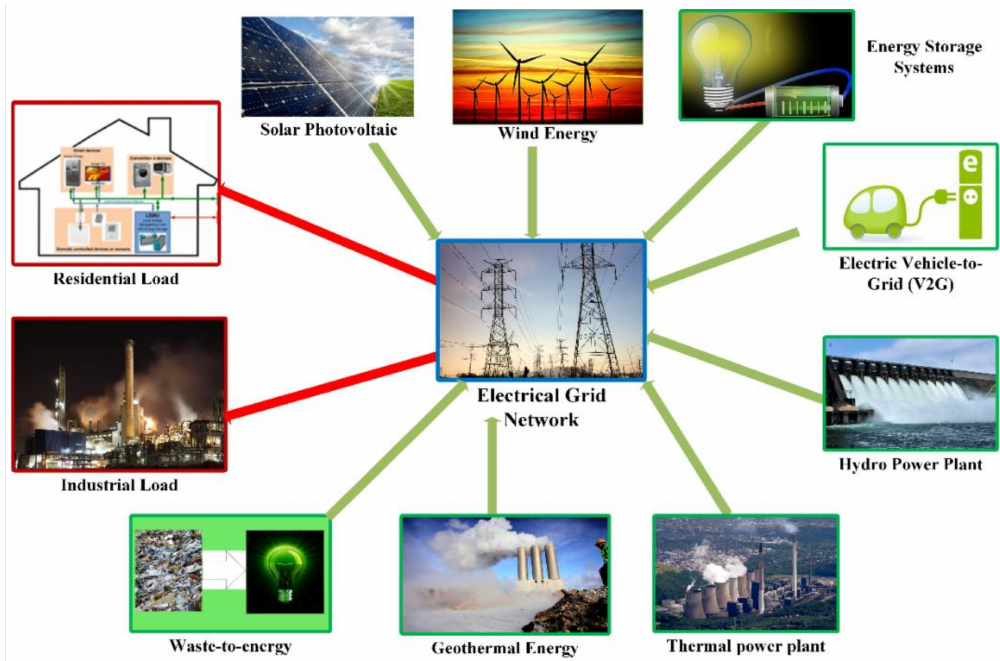
Figure 4. Various types of energy sources in the smart